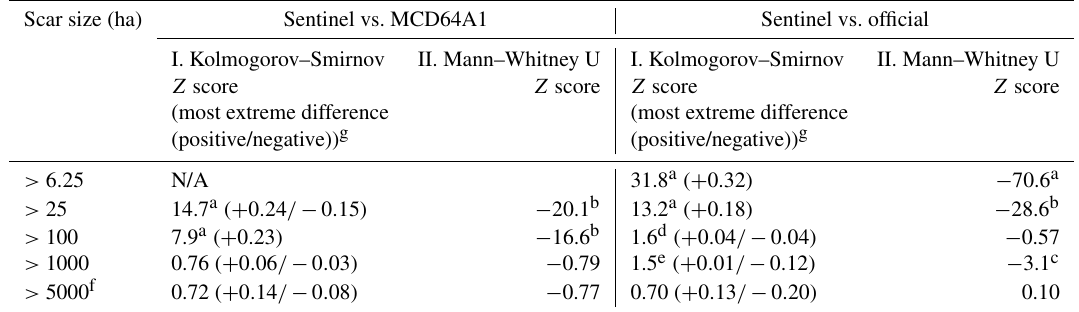
Table 4. Test statistics with respect to two-way differences in burned-area scar size frequency distributions, with respect to distribution shape and situation (Test I) or situation alone (Test II), for Sentinel estimates compared to either MCD64A1 or official estimates. Scar size (ha) Sentinel vs.